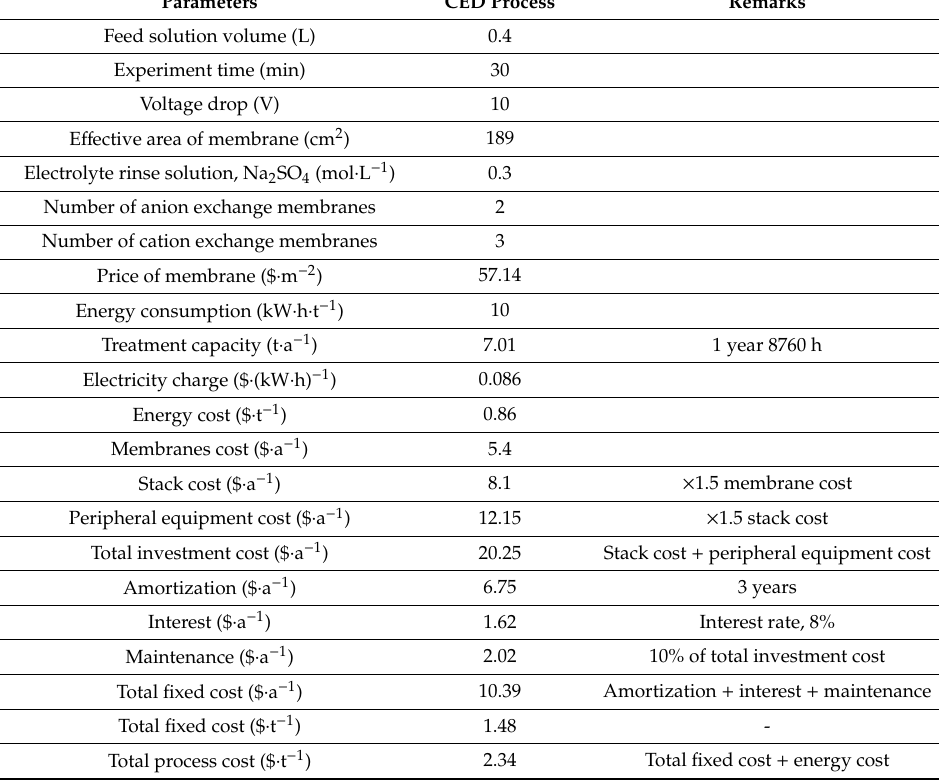
Table 2. The estimation of energy consumption and process cost for purification methyl sulfone by conventional electrodialysis